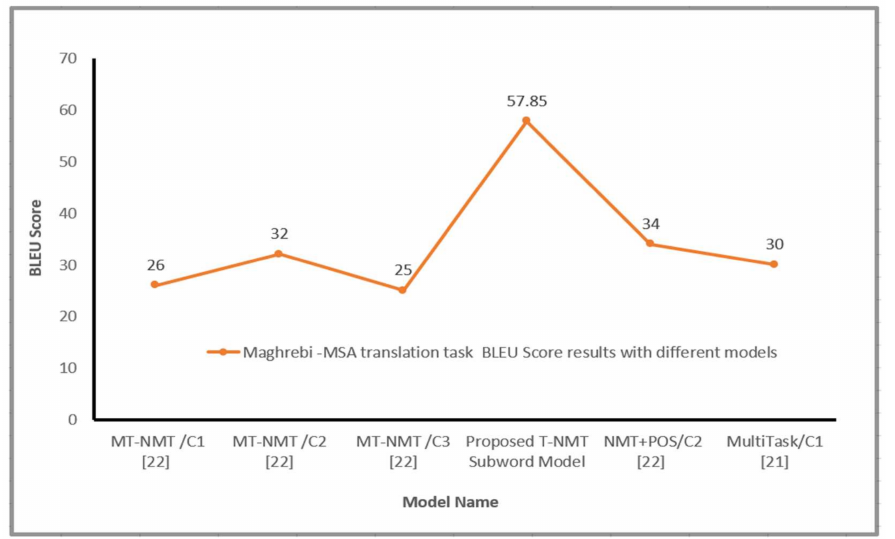
Figure 5. Maghrebi Arabic-MSA BLEU Score with different models, where C 1 is a random embed- ding, C 2 a pre-trained/Fast-text, C 3 a